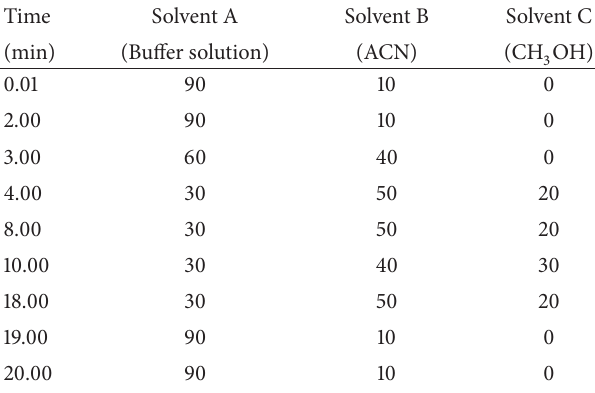
Table 1: Gradient program for simultaneous determination